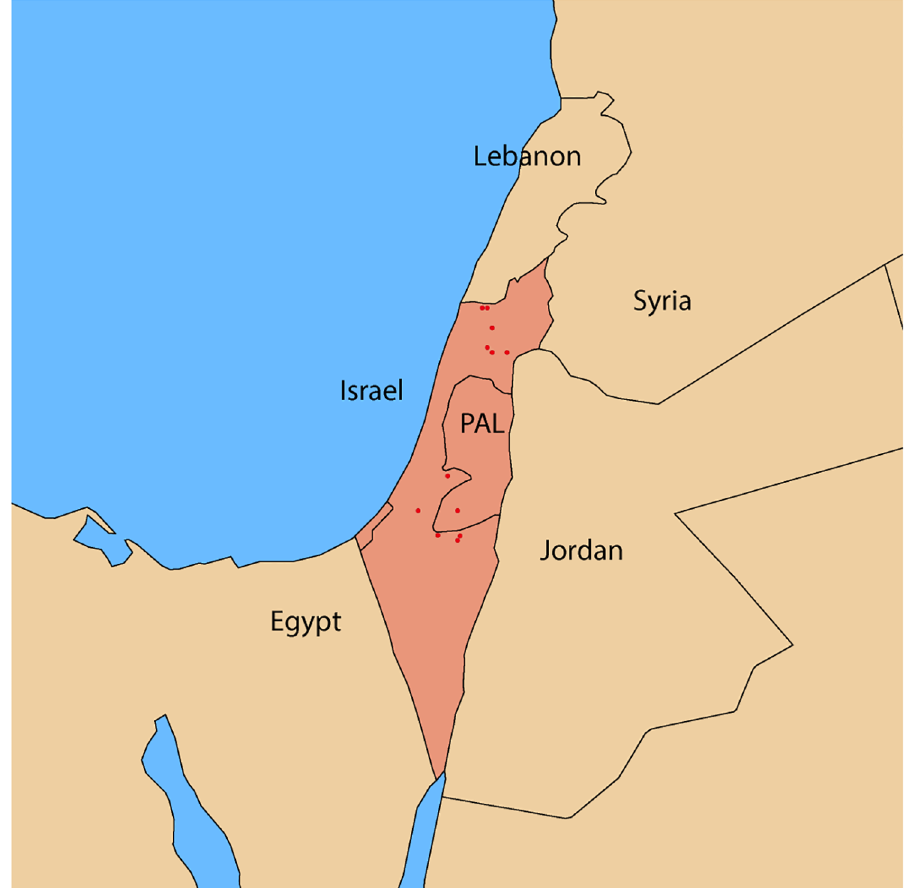
Fig 1. Location of PPR outbreaks in Israel (1993–2014). Sampling locationsare plotted in red, GPS co- ordinatesderived from Google maps API [49]. Comparisonsof the full length genome,and coding regions from the 18 Israel samples sequencedin this study. Indicatedthat the Israel isolates were more closely related than other groups (Table 2). Overall the Israel sequenceswere found to be 96.2 to 99.9% identicalat the nucleotide level. As has been previously reportedthe P gene was the most variable[50] and the matrix (M) gene the most conserved(Table 2).